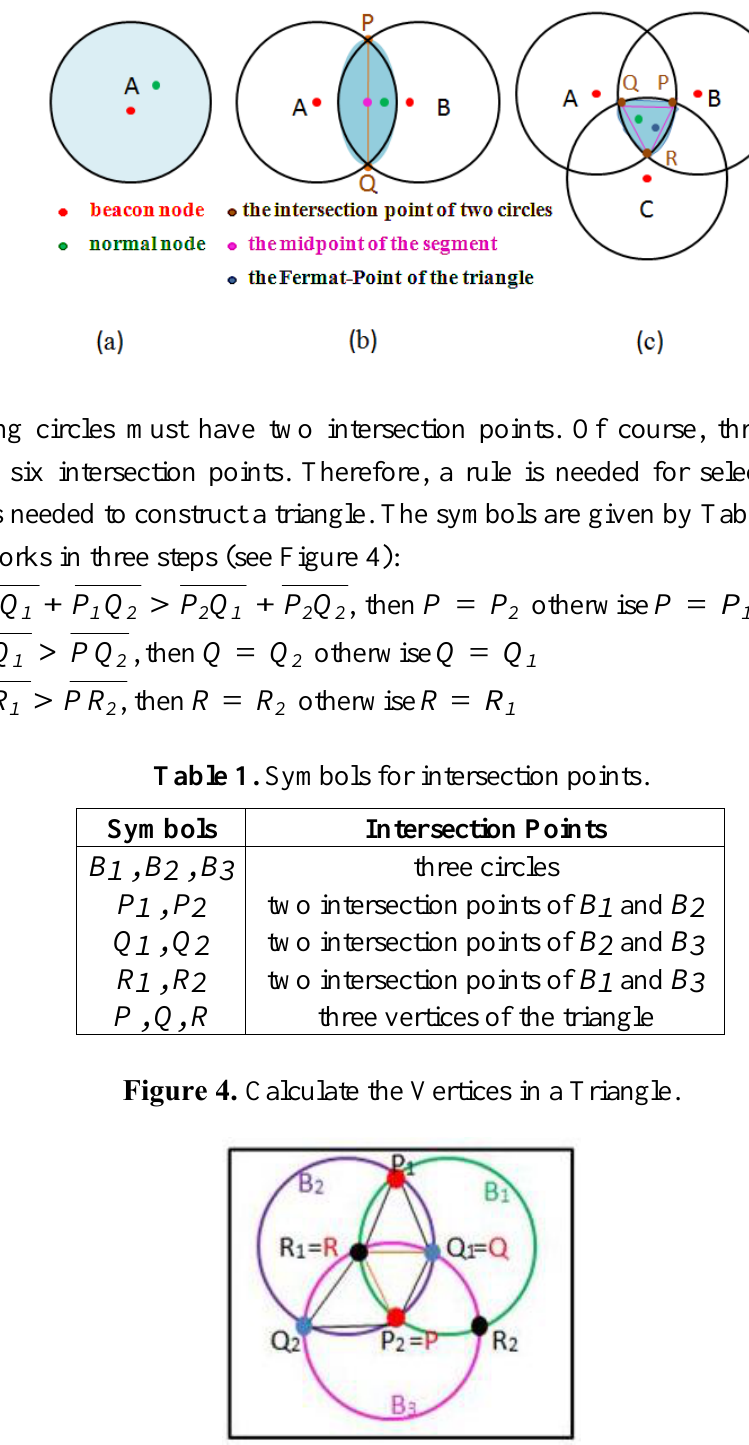
Figure 3. DFPLE Operation for Sensor Location Estimation.